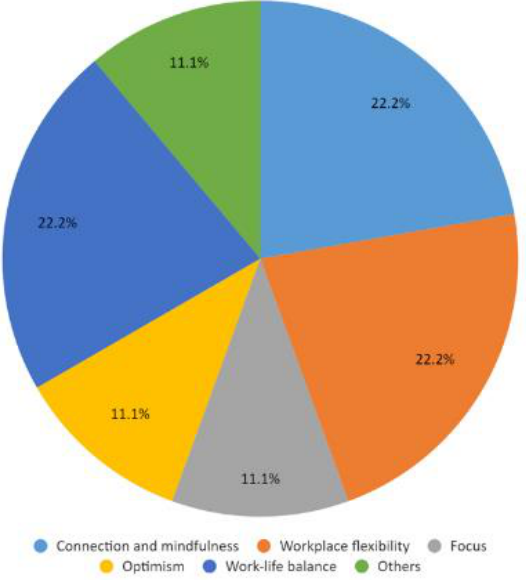
Figure 10. Responses from participants related to the lessons learned from the pandemic. (Kindly note that these results are not representative of the